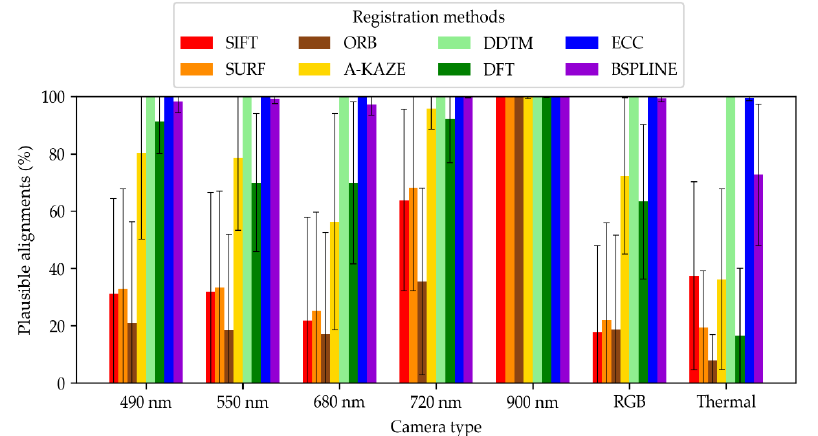
Figure 7. Average and standard deviation of plausible alignments percentages at all the acquisition dates compared for each camera and for each registration method.